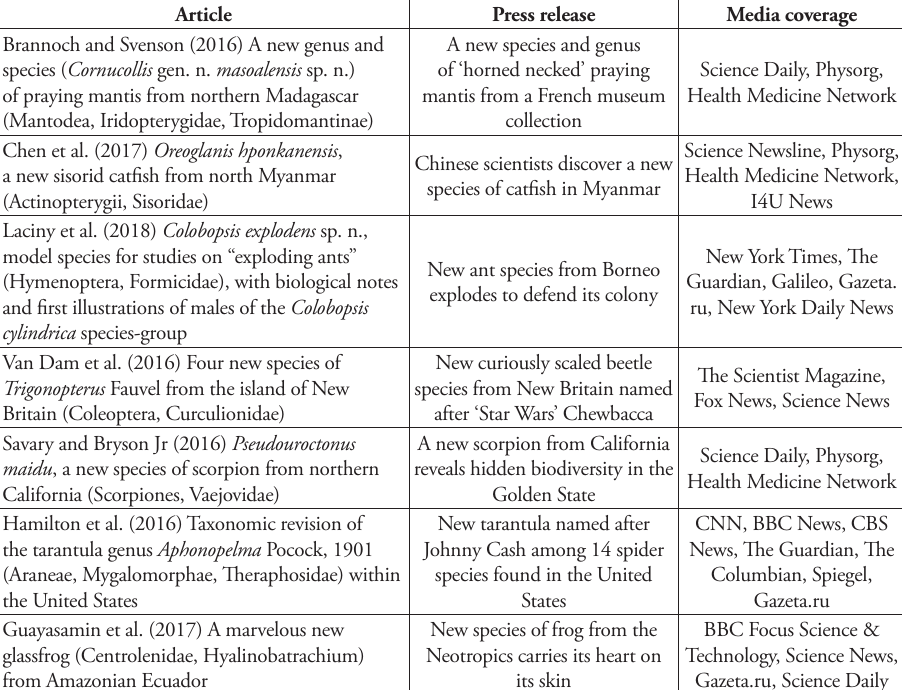
Table 5. The top ten ZooKeys papers that attracted largest media